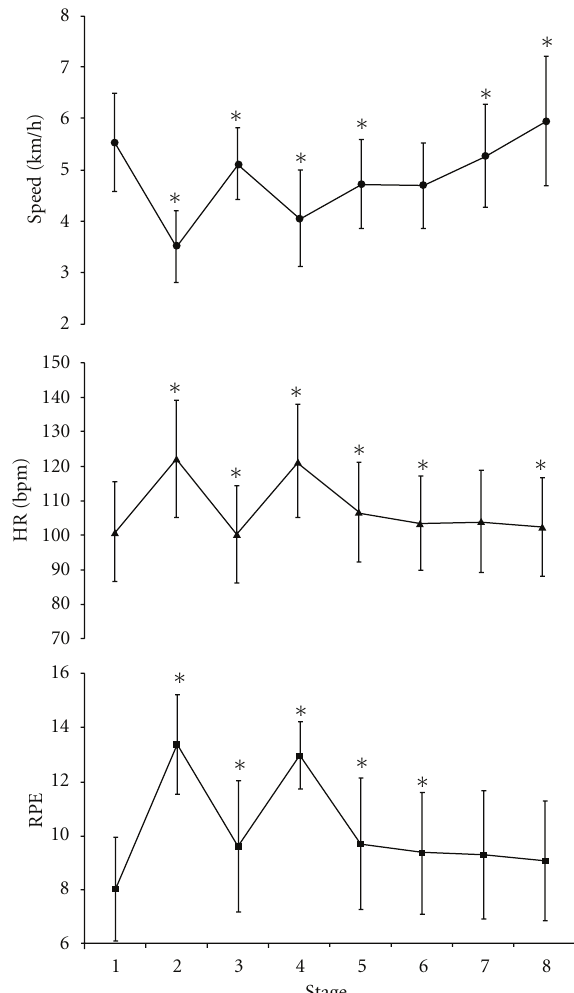
Figure 2: Means ( ± SD) of walking velocity, HR and RPE across the eight stages of the self-paced walk. ∗ Significant change from antecedent stage ( P < .